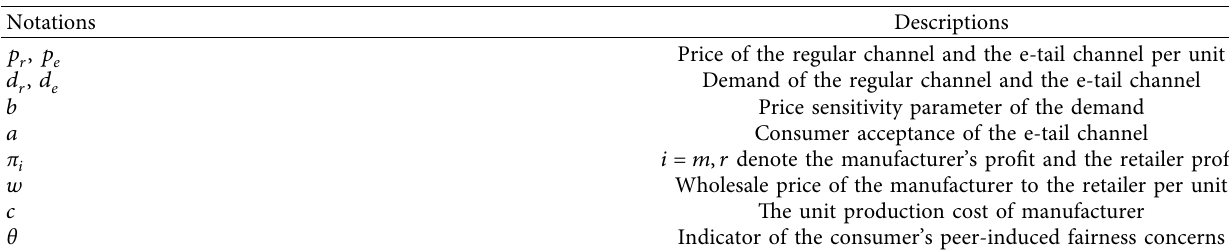
Figure 5: Price differences under three models (a) when a � 0 . 25 ,b � 0 . 2 , c � 0 . 8 and (b) when a � 0 . 5 , b � 0 . 2 ,c � 0 . 8. Table 1: Parameter